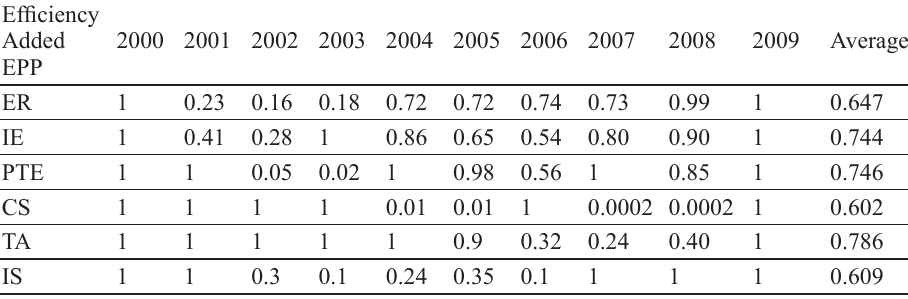
Table 2. The results of adding one input to DEA with ME as non discretionary input